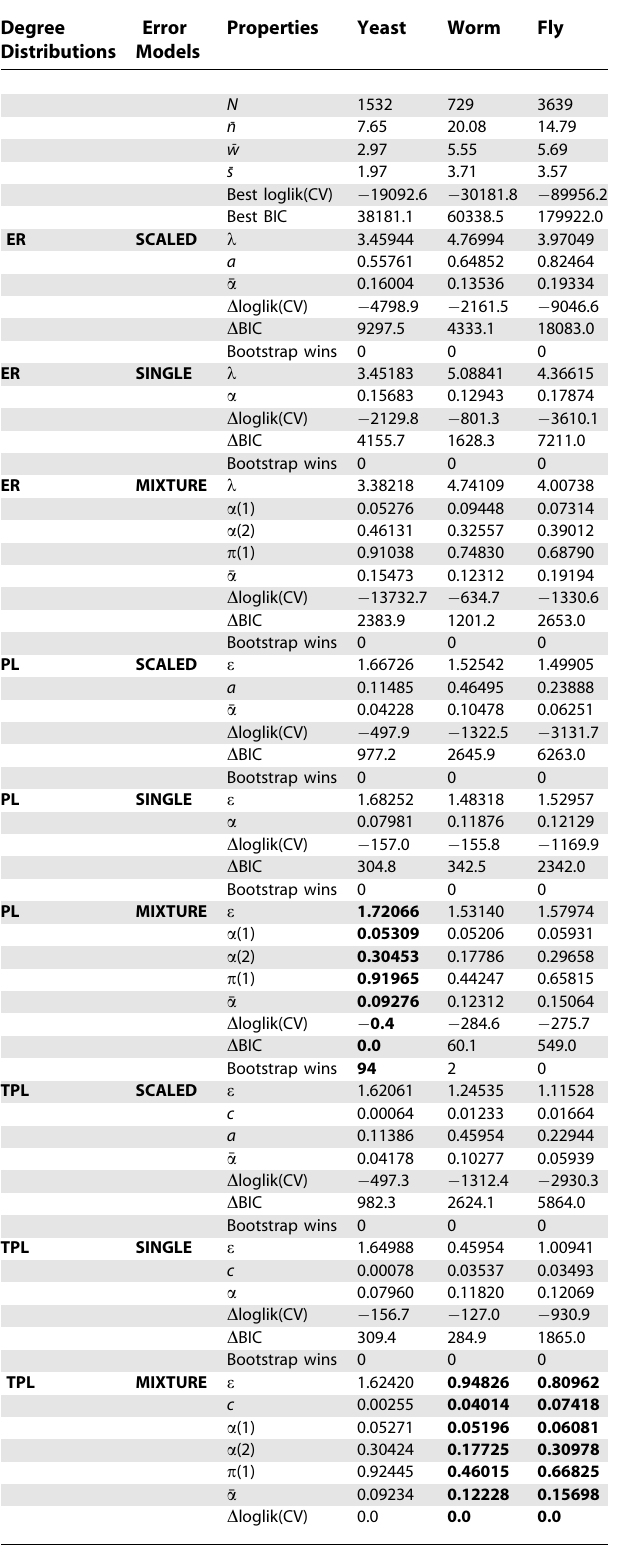
Table 2. Known Properties of the Experimental Datasets Are Total Number of Baits, N ; Mean Number of Preys Sampled per Bait, ¯n ; Mean Number of Unique Preys, ¯w ; and Mean Number of Singleton Preys,